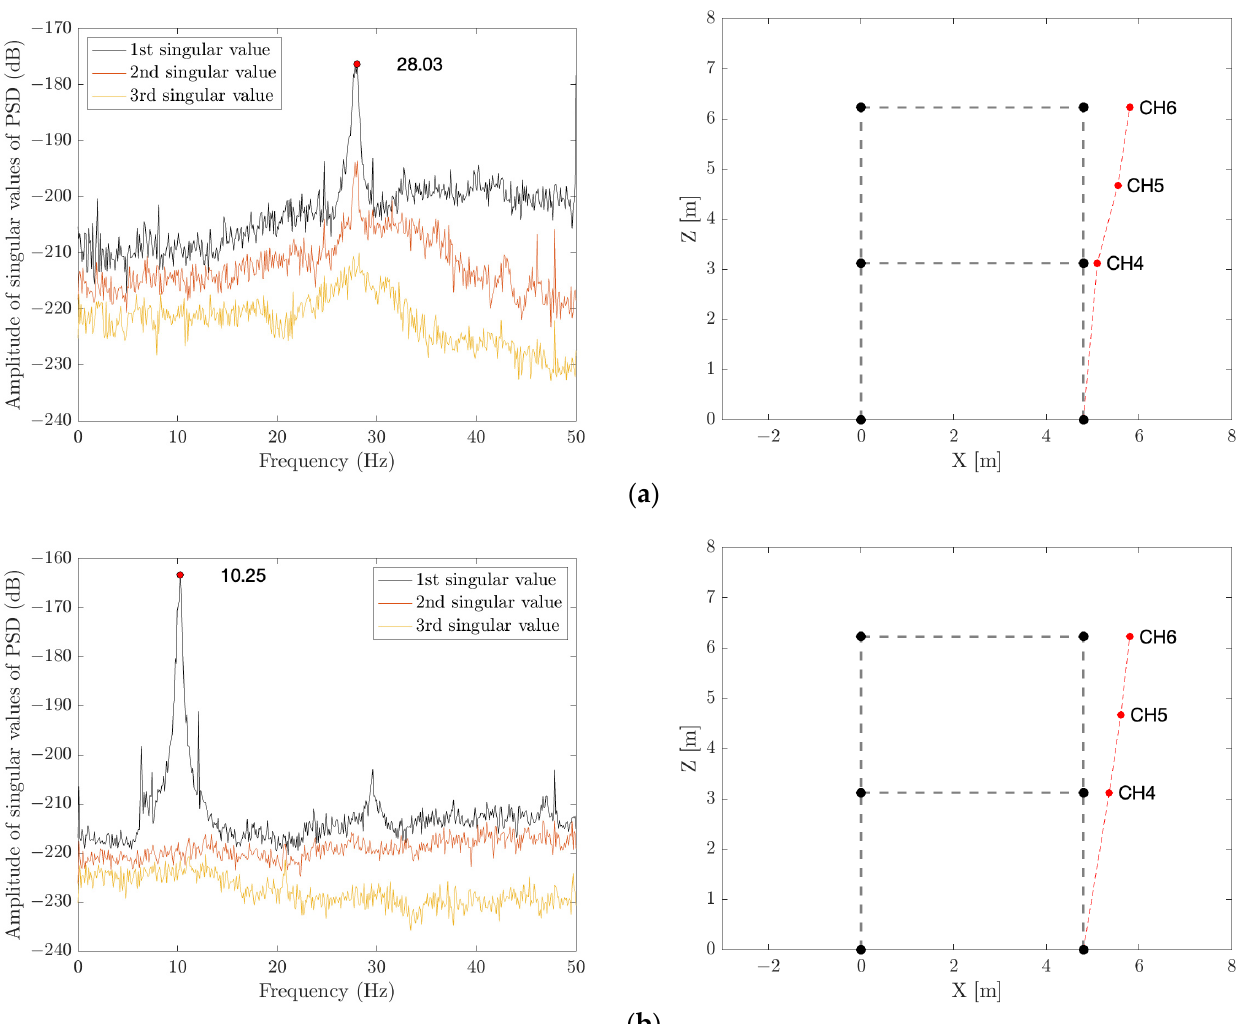
Figure 5. Outputs from FDD output-only modal identi fi cation tests: (a) Plot of the singular values and modal shape of test on F2_4S_M in the undamaged con fi guration; (b) plot of the singular values and modal shape of test on F2_4S_M in the damaged con fi guration.